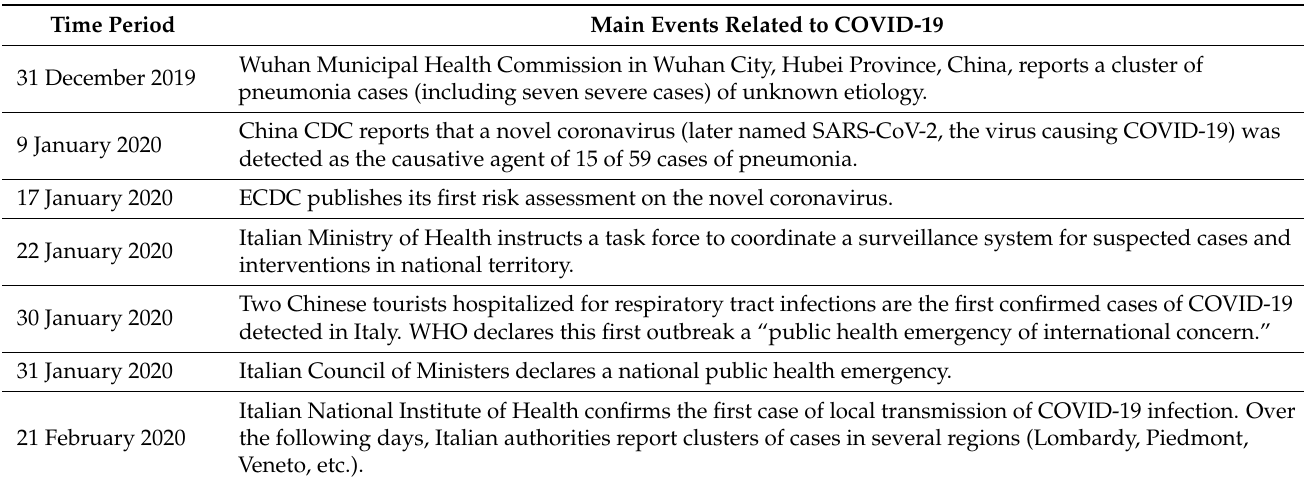
Table 1. Timeline of the COVID-19 pandemic in